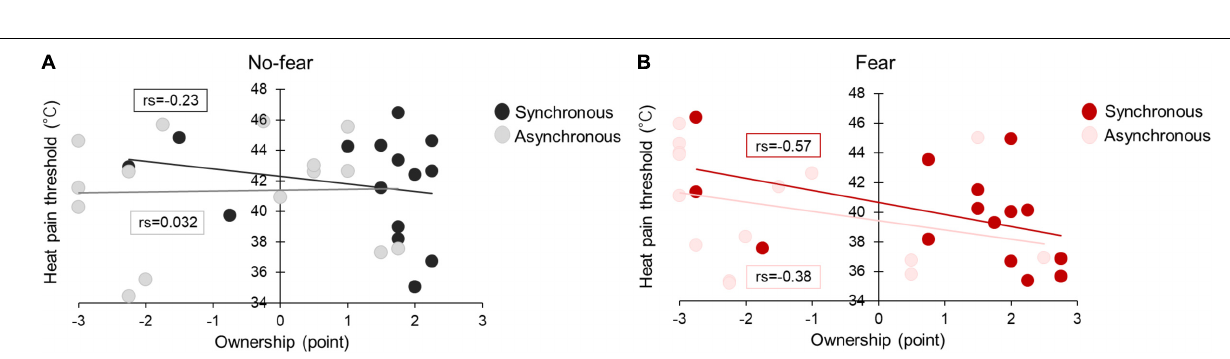
FIGURE 6 | HPT (A) , questionnaire (B) , EDA (C) , and unpleasantness (D) in Experiment 2.